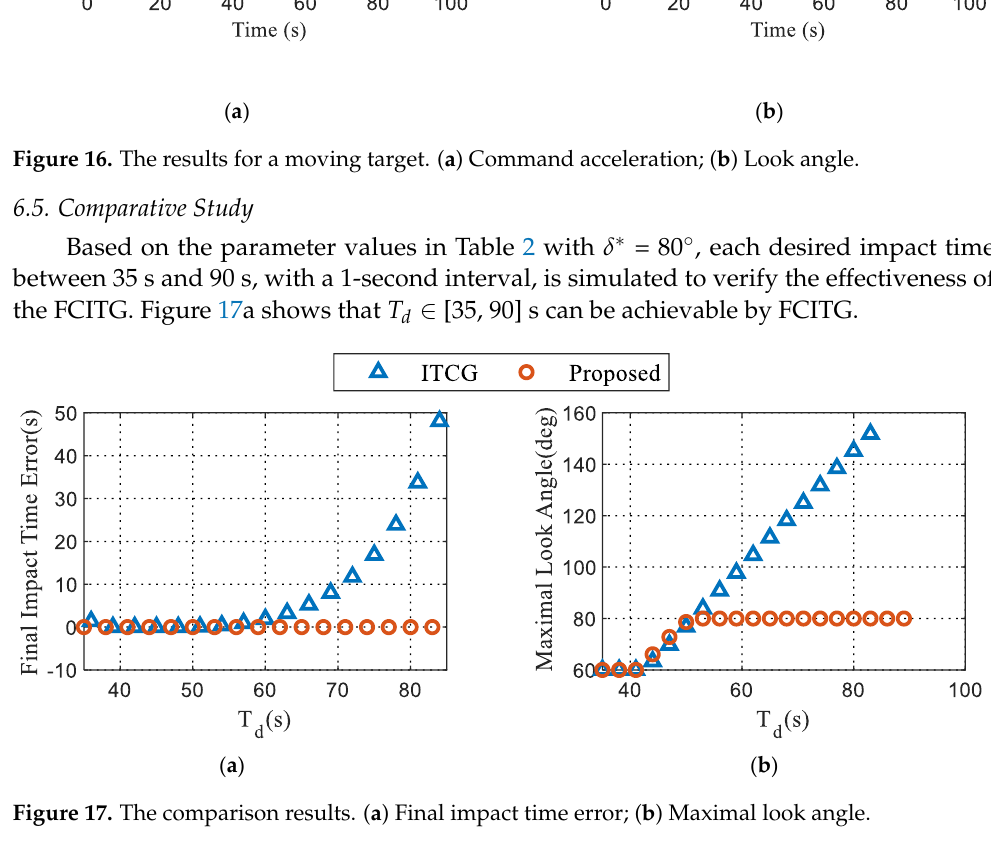
Table 6. Characteristics for